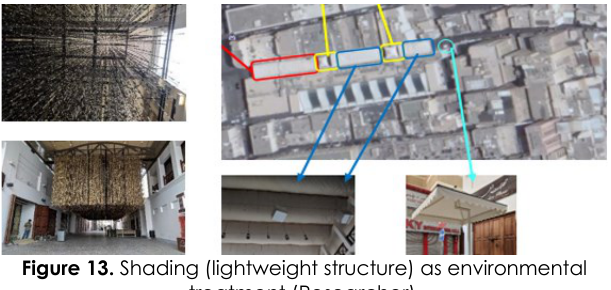
Figure 13. Shading (lightweight structure) as environmental treatment (Researcher).